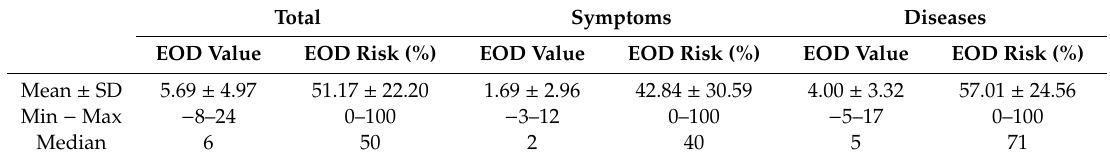
Table 2. EOD value and risk of symptoms, diseases and total situation ( n =